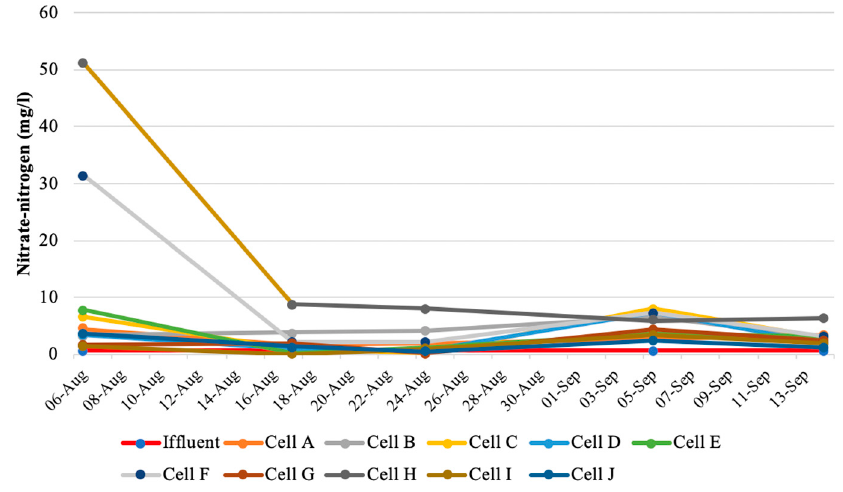
Figure 11. Variation in the nitrate-nitrogen concentrations with time.